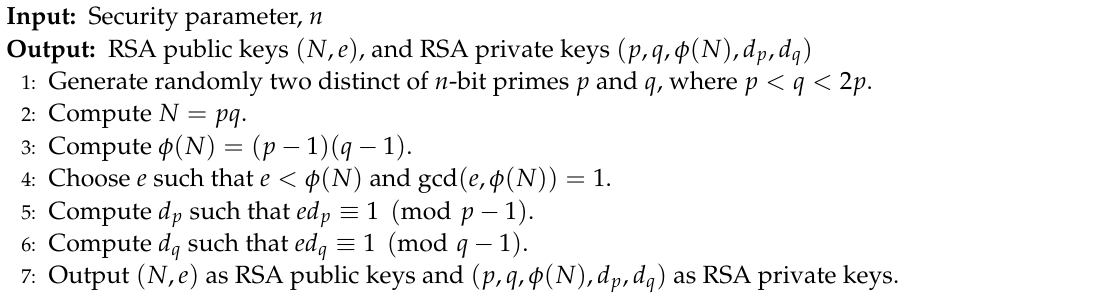
Algorithm 1 Chinese remainder theorem (CRT)-RSA Key Generation